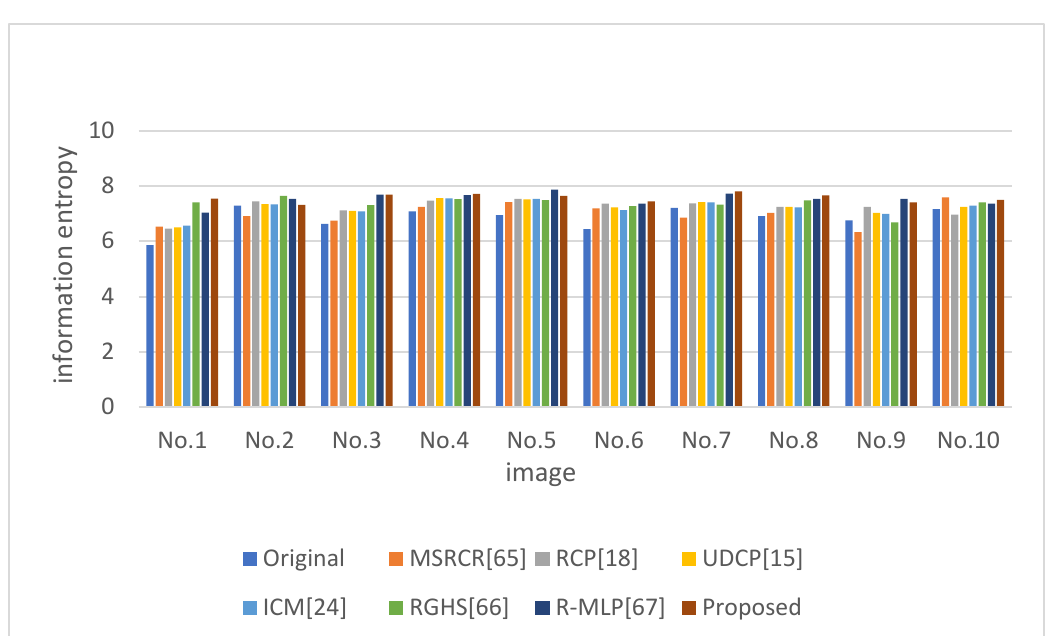
Figure 12. Comparison of UCIQE [15,18,24,65–67].